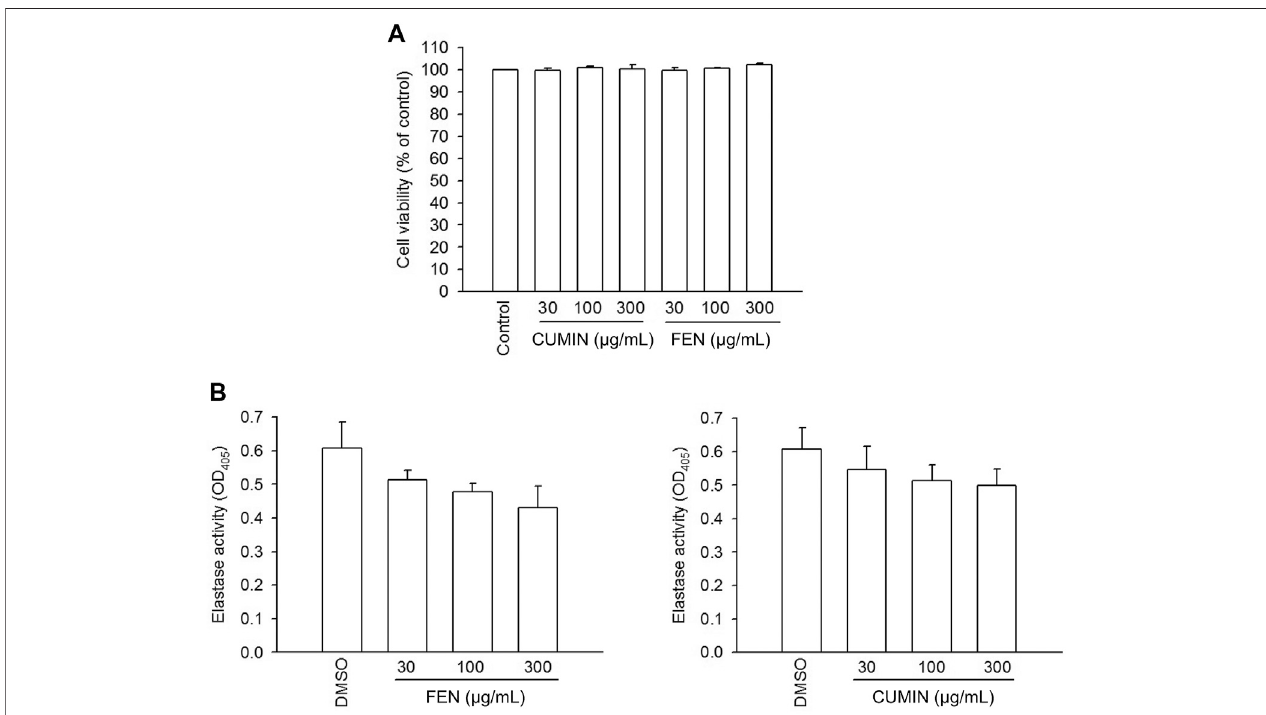
FIGURE 3 | LDH release viability assay in human neutrophils, and elastase enzymatic activity in cell-free system. (A) Human neutrophils were incubated with 0.1% DMSO(ascontrol),fennel(FEN,30 – 300 μ g/ml),orcumin(CUMIN,30 – 300 μ g/ml)volatileoils,for15 min.TheevaluationofcellviabilitywasbasedonLDHrelease,which wasexpressedasapercentageofenzymereleasedbysamplestreatmentcomparedwithuntreatedcontrol(DMSO)andatotalrelease(0.1%TritonX-100).Theanalysis was performed by using an enzyme-associated immunosorbent assay and OD was read at 490 nm. The data are shown as mean ± S.E.M. ( n (cid:2) 3). (B) Human neutrophils were incubated with fMLF/CB for 15 min. The elastase supernatant was obtained and incubated with DMSO (as control), fennel (FEN, 30 – 300 μ g/ml), or cumin(CUMIN,30 – 300 μ g/ml)volatileoilsfor2 minbeforetheadditionofsubstrate(100 μ M).Elastaseactivitywasmeasuredat405 nm.Dataarepresentedasmeans ± S.E.M. ( n (cid:2) 3). * p < 0.05 compared with the control